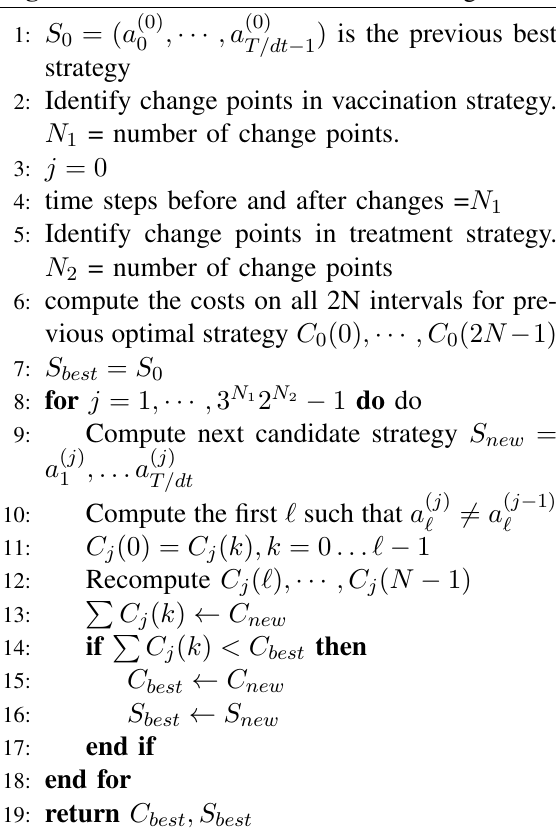
Algorithm 3 Pseudocode for Part III of